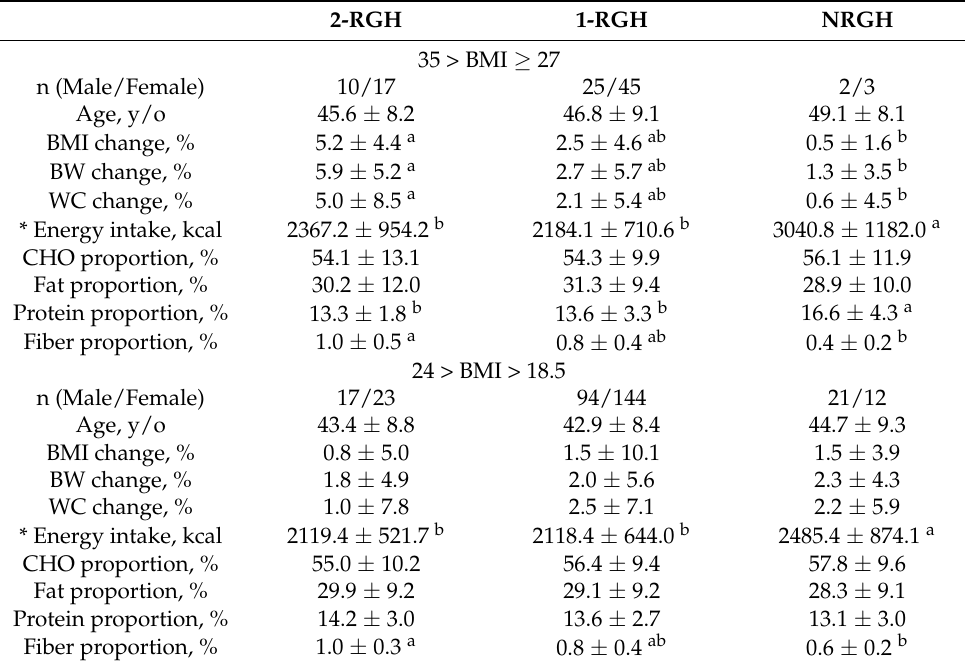
Table 4. Comparison of the differences in anthropometric changes and dietary status among three haplotypes in obese individuals over 18-month